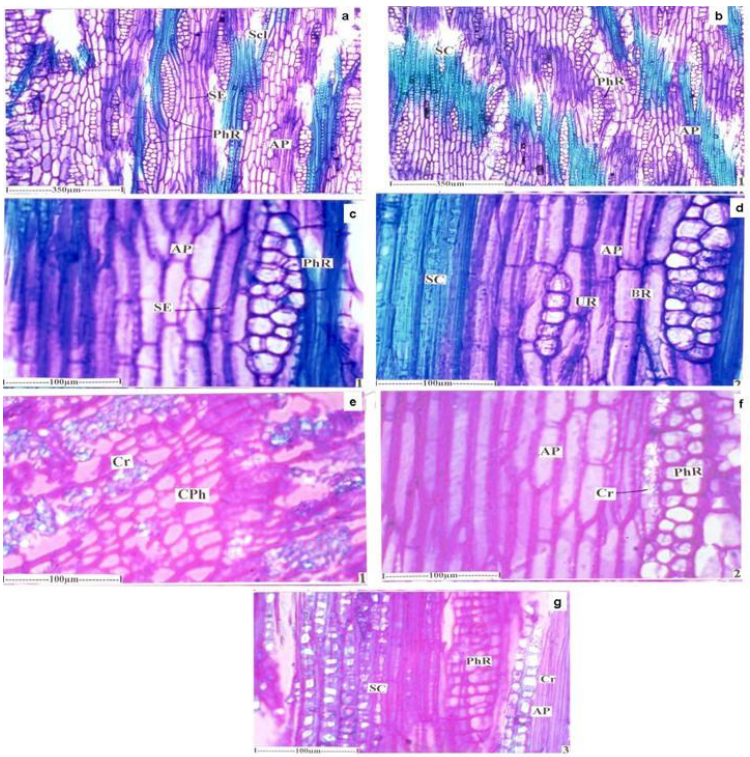
Figure 3. a and b) TLS of phloem showing the phloem rays and parenchyma, c) and d) TLS of phloem rays, e) T.S. of –showing crystals in the sclerenchyma cells, f) TLS of phloem showing crystals in the ray cells, g) crystals in the fibres and parenchyma cells. (AP;